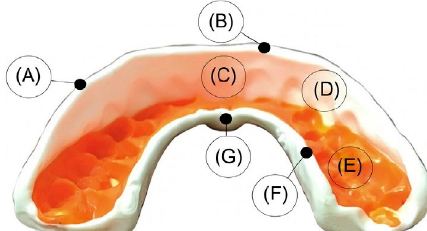
Figure 4. Basic design of a mouthguard: ( A ) edge of buccal flange; ( B ) edge of labial flange; ( C ) labial flange; ( D ) buccal flange; ( E ) occlusal surface; ( F ) edge of palatal flange; and ( G ) palatal flange [38]. Published by Elsevier.